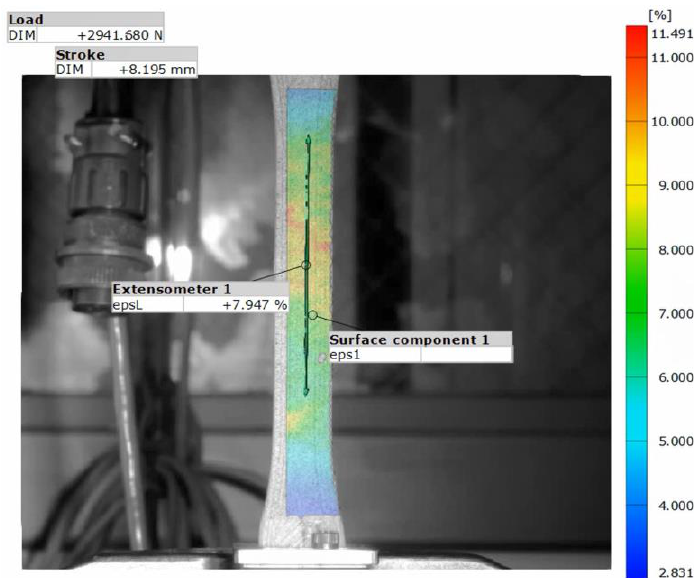
Figure 3. Example of DIC analysis of tensile test specimen.